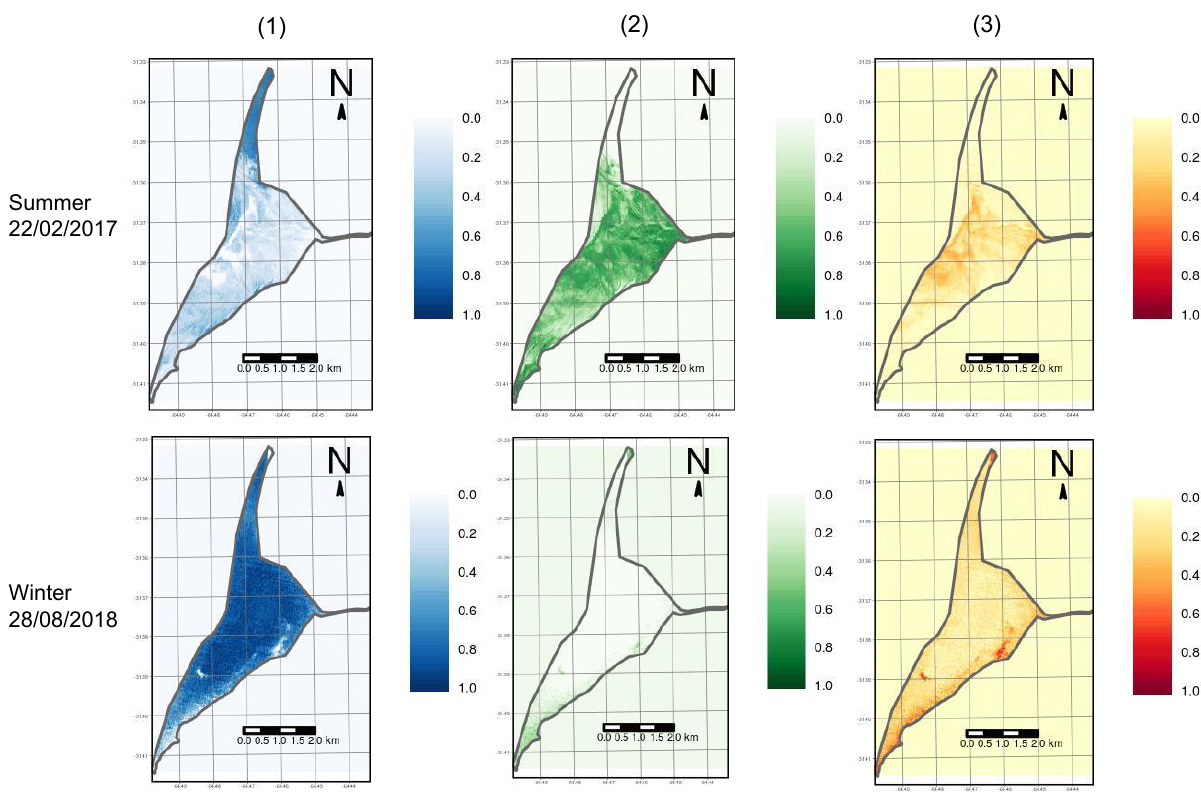
Figure 3. Abundances maps of temporal endmembers extracted using the summer and winter images of